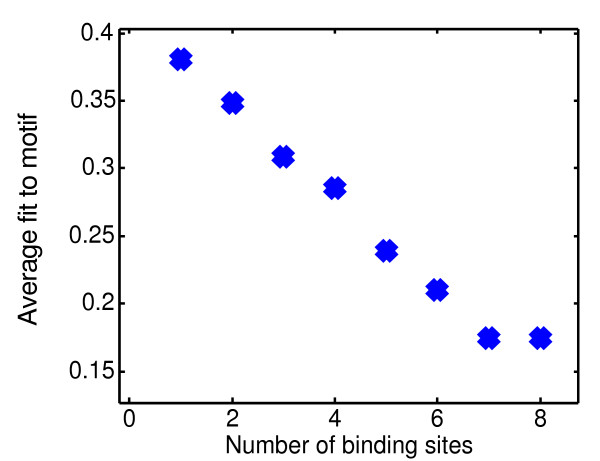
'Fuzziness' of Reb1 binding sites. Average fit of Reb1 binding sites to the consensus matrix, as a function of the number of binding sites within the promoter they appear in.